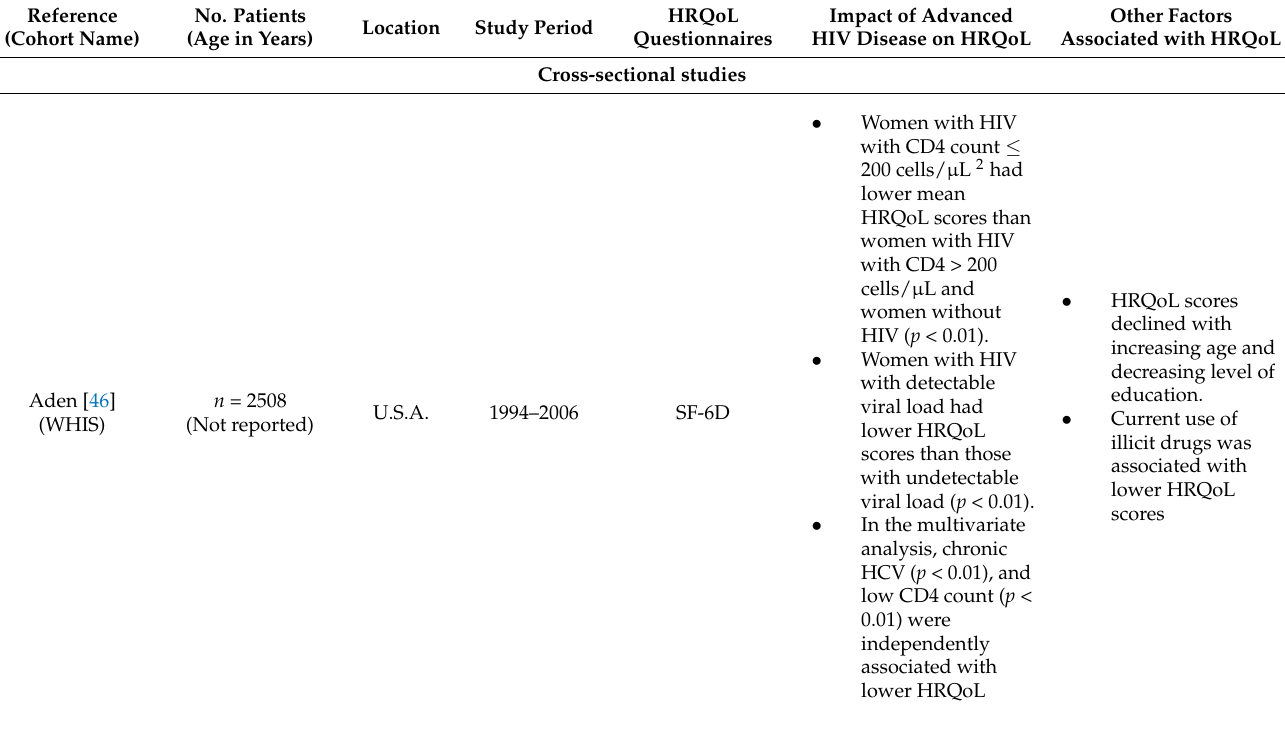
Table 3. Impact of advanced HIV disease on health-related quality of life. Cross-sectional and longitudinal